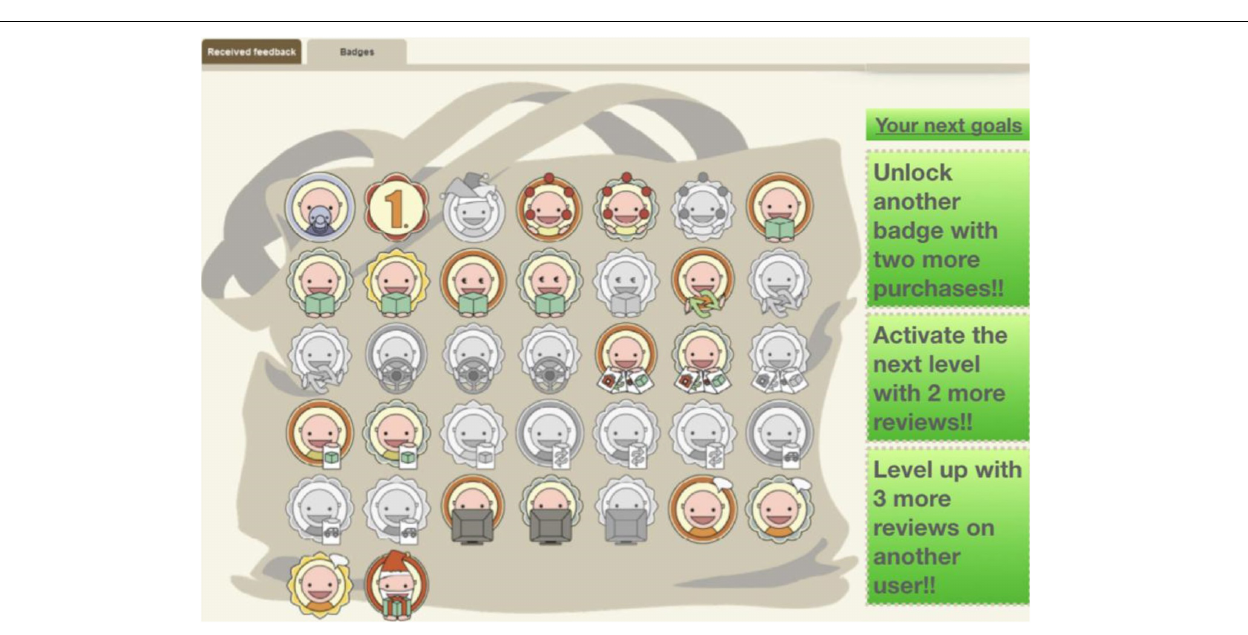
FIGURE 3 | The conceptual omnichannel retailer with gamification